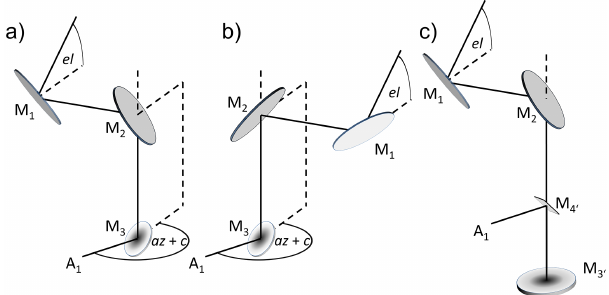
Figure 4. Geometry of the Zugspitze solar tracker optics. (a) Cur- rent optical setup after September 2014, Flip 1. (b) Current setup, Flip 0. (c) Optical setup before September 2012.